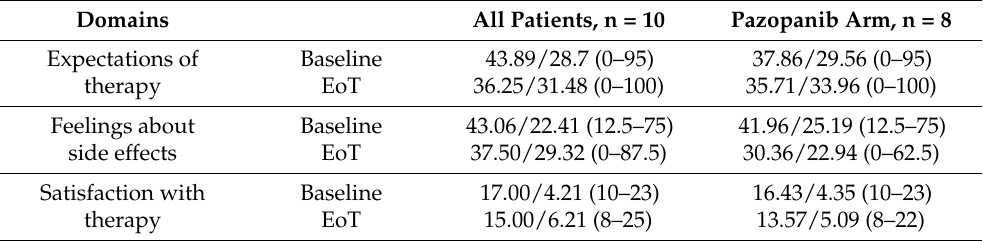
Table 2. Results Cancer Therapy Satisfaction Questionnaire (CTSQ). Given numbers are mean/SD and (min–max); EoT, end of treatment; Score ranging from 0–100 for each domain, with a higher score associated with the best outcome.